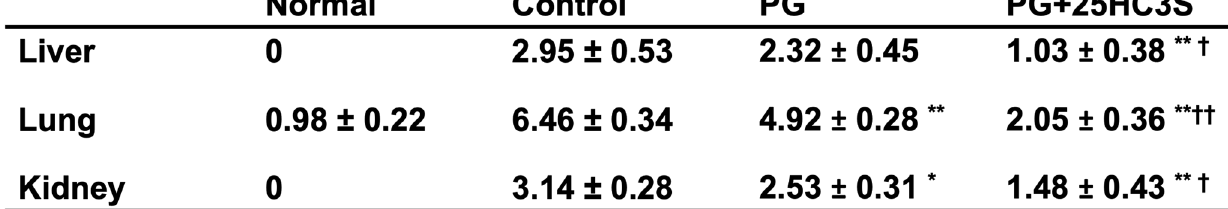
Figure 2. Morphological study of liver, lung, and kidney tissues. 12-week-old female C57BL/6J mice were administered either with control, vehicle or 25HC3S at 2 h before APAP (600 mg/kg) treatment ( n = 4 for each group). The liver, lung, and kidney tissues were harvested at 24 h or at dying following the injection of APAP for morphological study. Tissues from age-matched mouse without any treatment were used as normal control. ( A ) The paraffin-embedded tissue sections were stained using H&E method and photographed for evaluation. Representative photos are shown at × 100 magnification (bar = 100 µ m). Inserts are shown at × 400 magnification of the boxed areas (bar = 10 µ m). Normal represents normal mice without any treatment ( n = 4); Control, PG vehicle-treated mice; 25HC3S, 25HC3S-pretreated mice. ( B ) Ten images per sample were taken at × 400 magnification by light microscope and scored by two pathologists in a blinded manner. The severity of microscopic tissue injury was graded as indicated. Normal: normal mice without treatment; Control: mice with PG vehicle and APAP injection; 25HC3S: mice with 25HC3S and LPS injection ( n = 4). The symbol * indicates p < 0.05 and ** indicates p < 0.01 versus Control group; † indicates p < 0.05 and †† indicates p < 0.01 versus PG